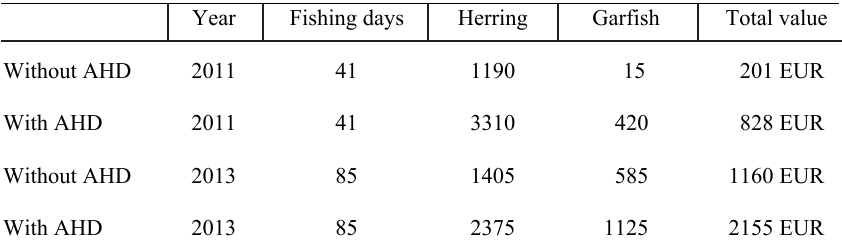
Table 3. Catch (kg, only unharmed fish), number of fishing days, and monetary value of two pound nets during the 2011 and 2013 spring fishing seasons in locality A